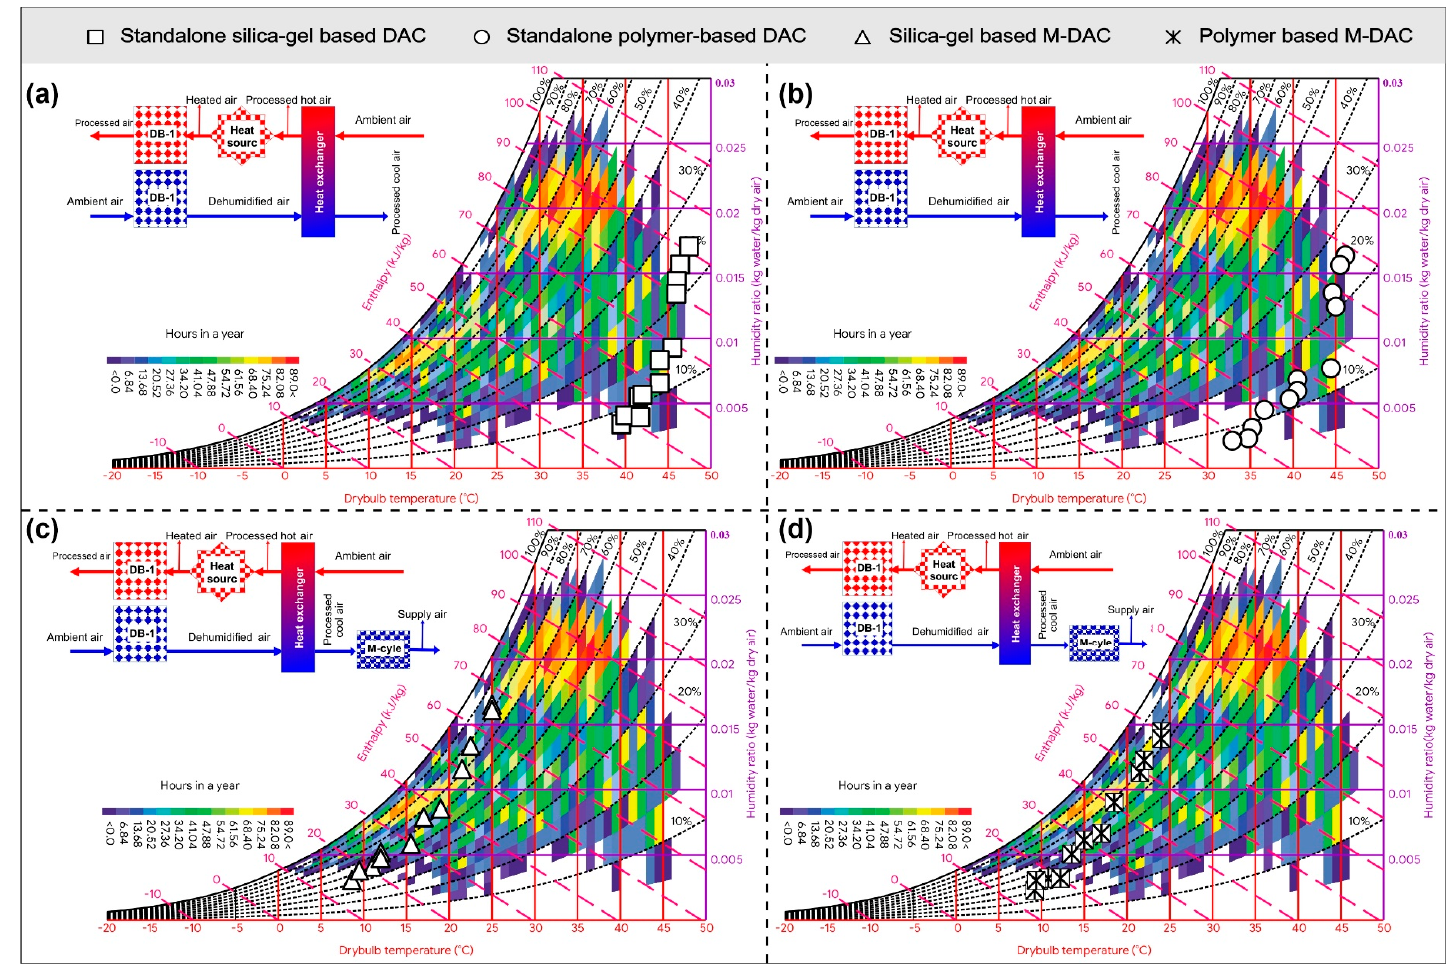
Figure 11. Psychrometric representation of monthly profile for ( a ) standalone silica-gel-based DAC system, ( b ) standalone polymer-based DAC system, ( c ) silica-gel-based M-DAC system, and ( d ) polymer-based M-DAC system.